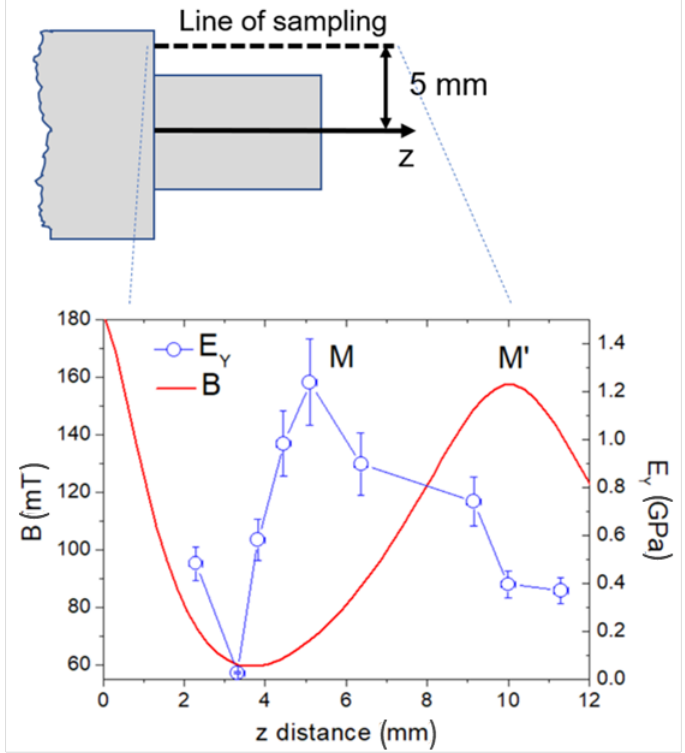
Figure 6. Graph of the Young’s modulus (blue curve) estimated via AFM nanoindentation and the field B (red curve), both taken along a straight line at a fixed (5 mm) distance from the z -axis.